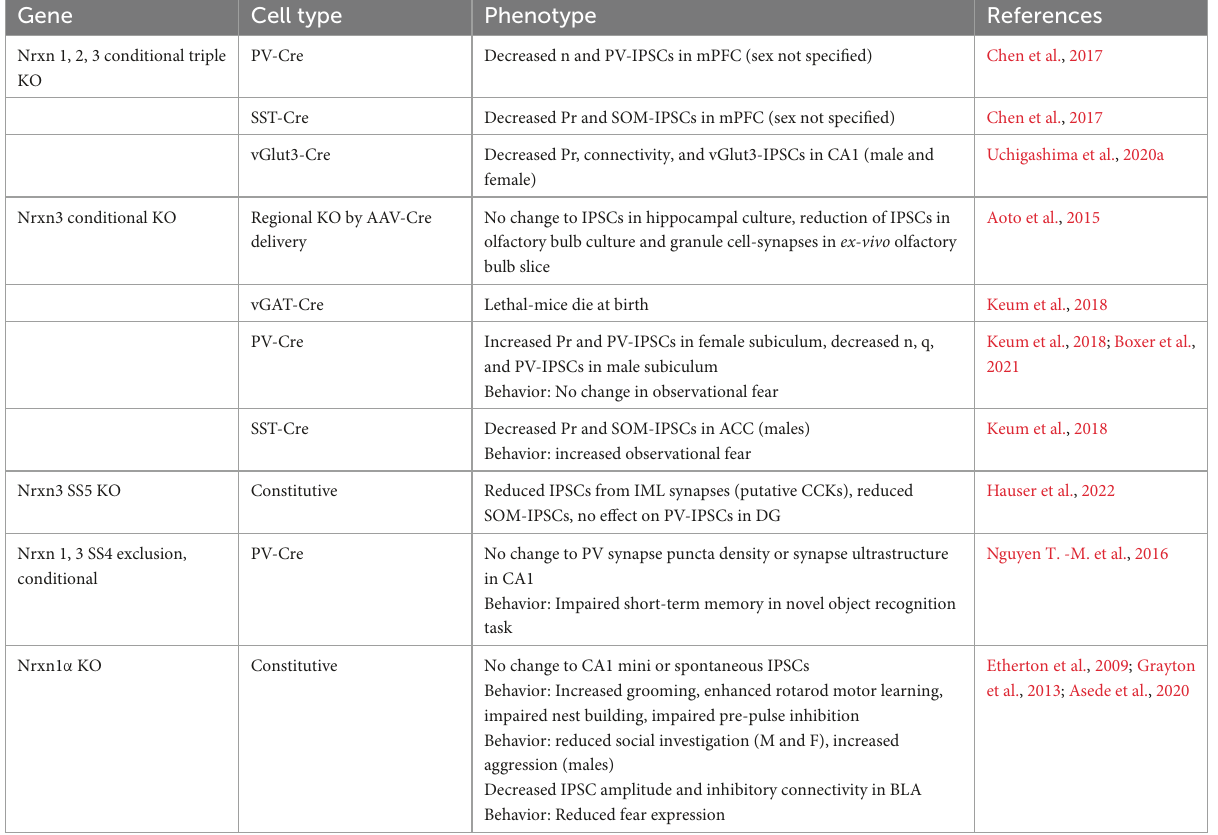
TABLE 1 Summary of inhibitory synaptic phenotypes and behavior following functional manipulations of neurexins in mice.